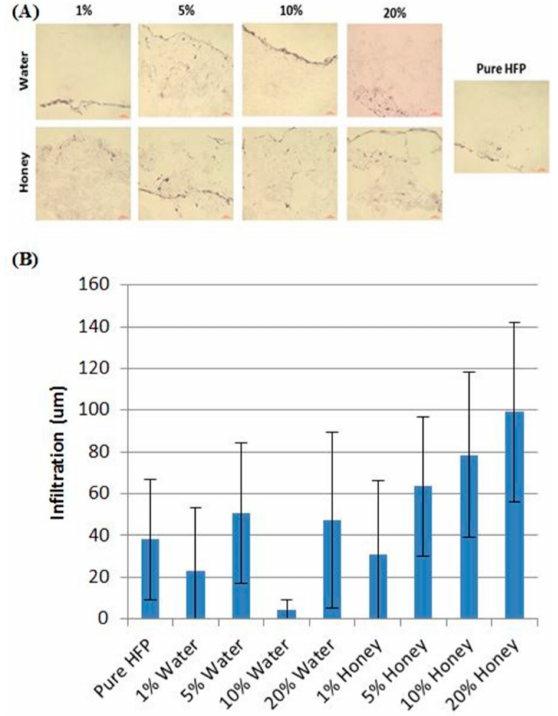
Figure 3. Honey induces fibroblast infiltration. ( A ) Representative images of H and E-stained honey templates and water controls after 28 days of fibroblast culture. ( B ) Cellular infiltration depth of the furthest 60 cells on each image. Reproduced with permission from Minden-Birkenmaier et al., Journal of Engineered Fibers and Fabrics ; published by INDA,